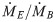
Steady state values of different parameters under different conditions.Plots showing long-time asymptotic values of (a) porosity at different growth rate ratio M˙E/M˙B, (b) porosity at different numbers of fimbriae per bacterial cell, and (c) average fraction of attached fimbriae at different numbers of fimbriae per bacterial cell. Solid lines indicate best-fit curves of quadratic form in (a) and (b) and logarithmic form in (c).